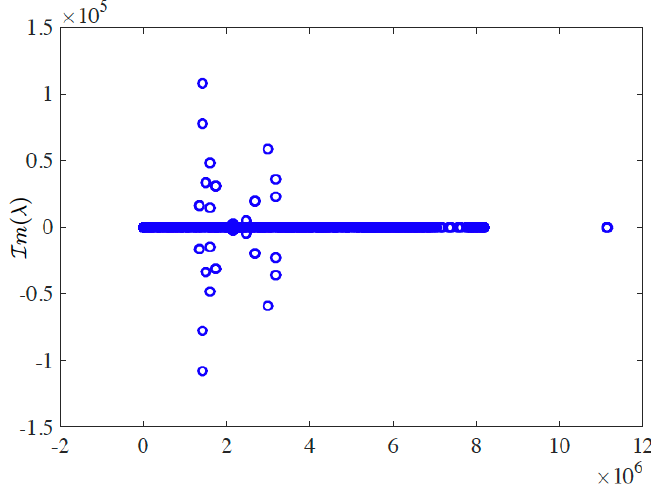
= 1 ( top left ), 0.0456 h N